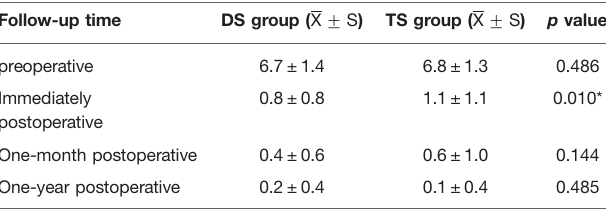
TABLE 3. | Comparison of VAS for leg pain between DS group and TS group.